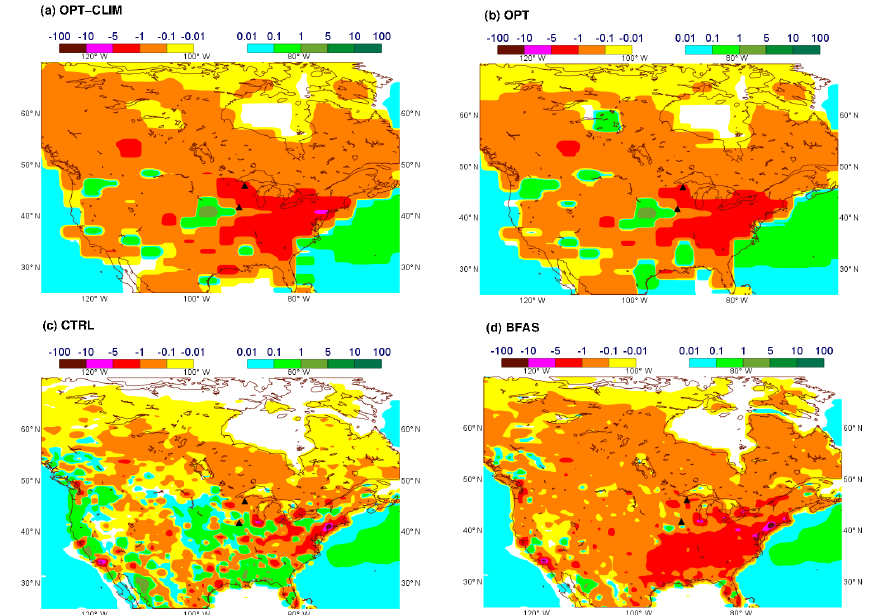
Figure 13. Monthly mean total CO 2 flux (µmolm − 2 s − 1 ) in March 2010 from (a) OPT-CLIM, (b) OPT, (c) CTRL and (d) BFAS experiments (see Table 2 for a description of the different experiments). The black triangles depict the location of the NOAA/ESRL tall towers plotted in Fig.